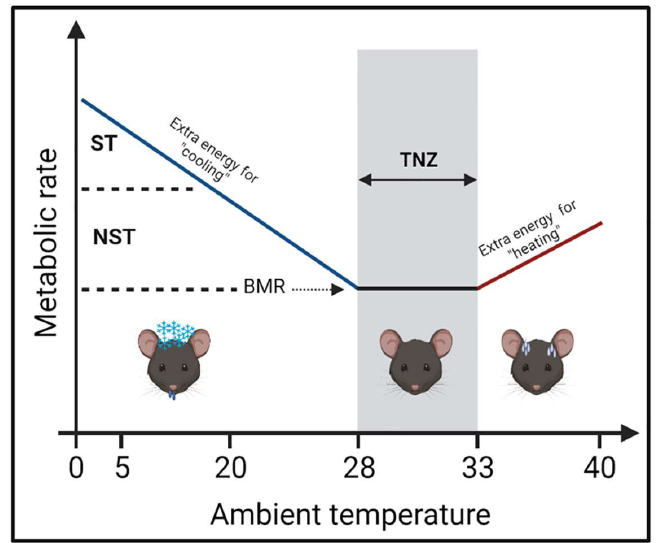
Figure 1. Thermoregulation of mice in response to ambient temperature. In ambient temperature below their TNZ, mice need extra energy for the “heating” process to maintain their body temperature. Oppositely, mice need extra energy for “cooling” when they are housed in an environment above their TNZ. In their TNZ, mice can maintain their basal metabolism without any requirement for thermogenic activity. BMR: basal metabolic rate; ST: shivering thermogenesis; NST: non-shivering thermogenesis; TNZ: thermoneutral zone.